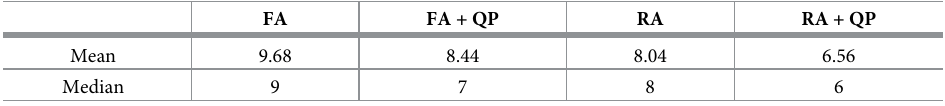
PLOS ONE | https://doi.org/10.1371/journal.pone.0226787 January 15,